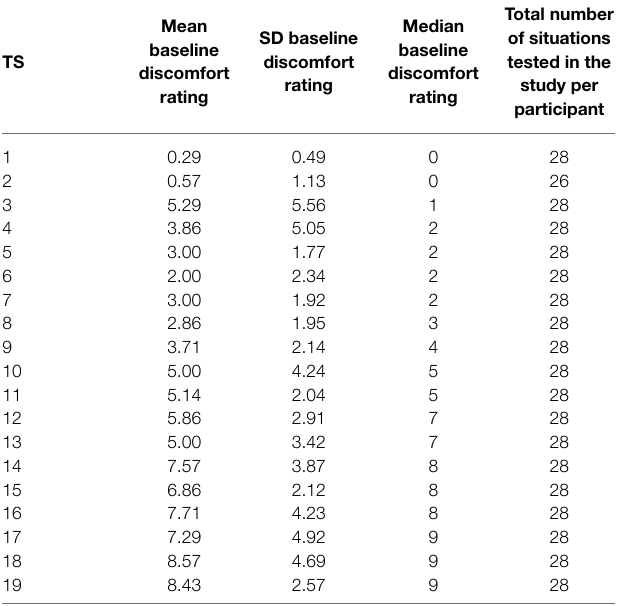
TABLE 2 | Descriptive statistics for the baseline discomfort ratings (arranged by median value) and total number of tested situations per participant. Mean baseline TS discomfort